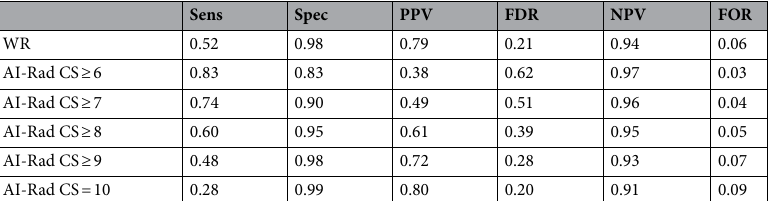
Table 3. Performance metrics of the radiologists (WR = written report) and the AI Rad Companion Chest X-ray (AI-Rad) for the detection of lung lesions. CS confidence score, PPV positive predictive value, NPV negative predictive value, FDR false discovery rate, FOR false omission